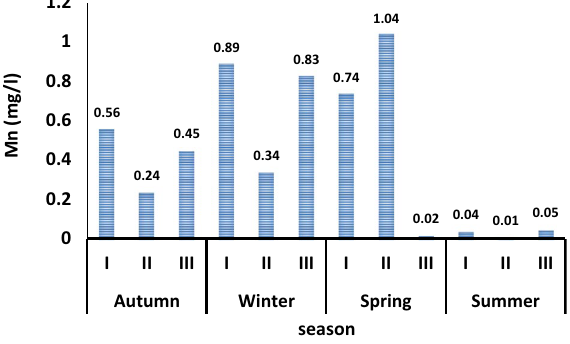
Fig. 3 Mn concentration (mg/L) in water samples from autumn 2018 to summer 2019 along the investigated area